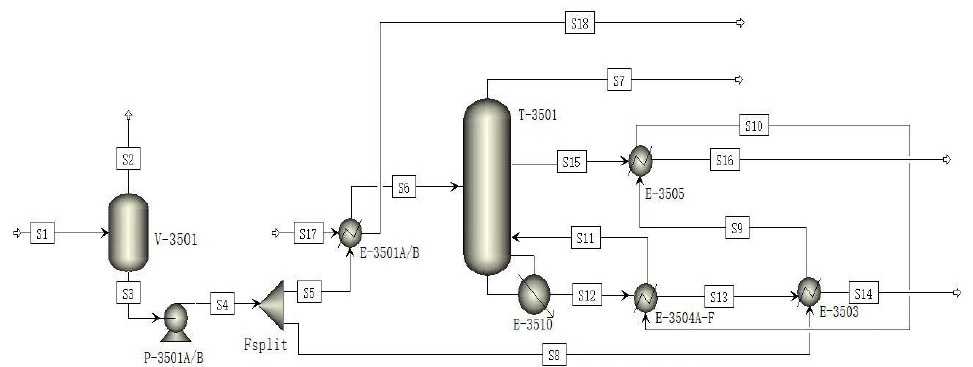
Figure 1. Simulation diagram of sour water stripping process. (V-3501: flash tank; P-3501A/B: pump; T-3501: stripper; E-3501A/B, E-3504A-F, E-3503, E-3505: heat exchanger; E-3510: reboiler).